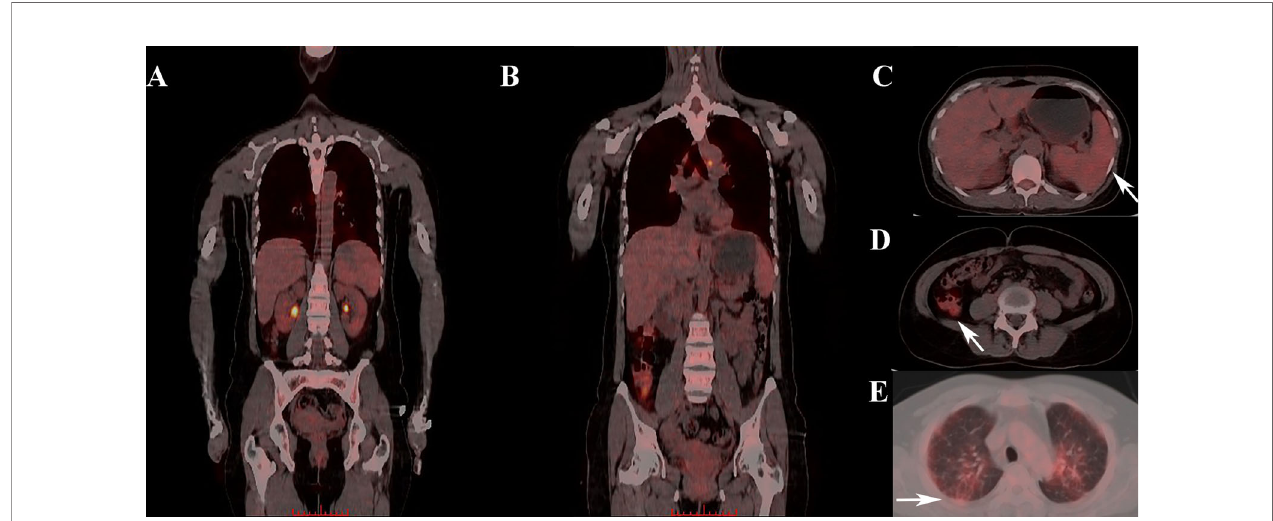
FIGURE 1 | Abnormal FDG uptake in one IIM patient who was later diagnosed with sHLH. (A, B) Whole-body PET/CT scan showing abnormal FDG uptake in multiple organs. (C) Elevated splenic FDG uptake in PET/CT scan (where the arrow pointed). (D) Elevated colon FDG uptake in PET/CT scan (where the arrow pointed). (E) Elevated pulmonary FDG uptake in PET/CT scan (where the arrow pointed). FDG, Fluorodeoxyglucose; IIM,diopathic in fl ammatory myopathy; sHLH, Secondary hemophagocytic lymphohistiocytosis.